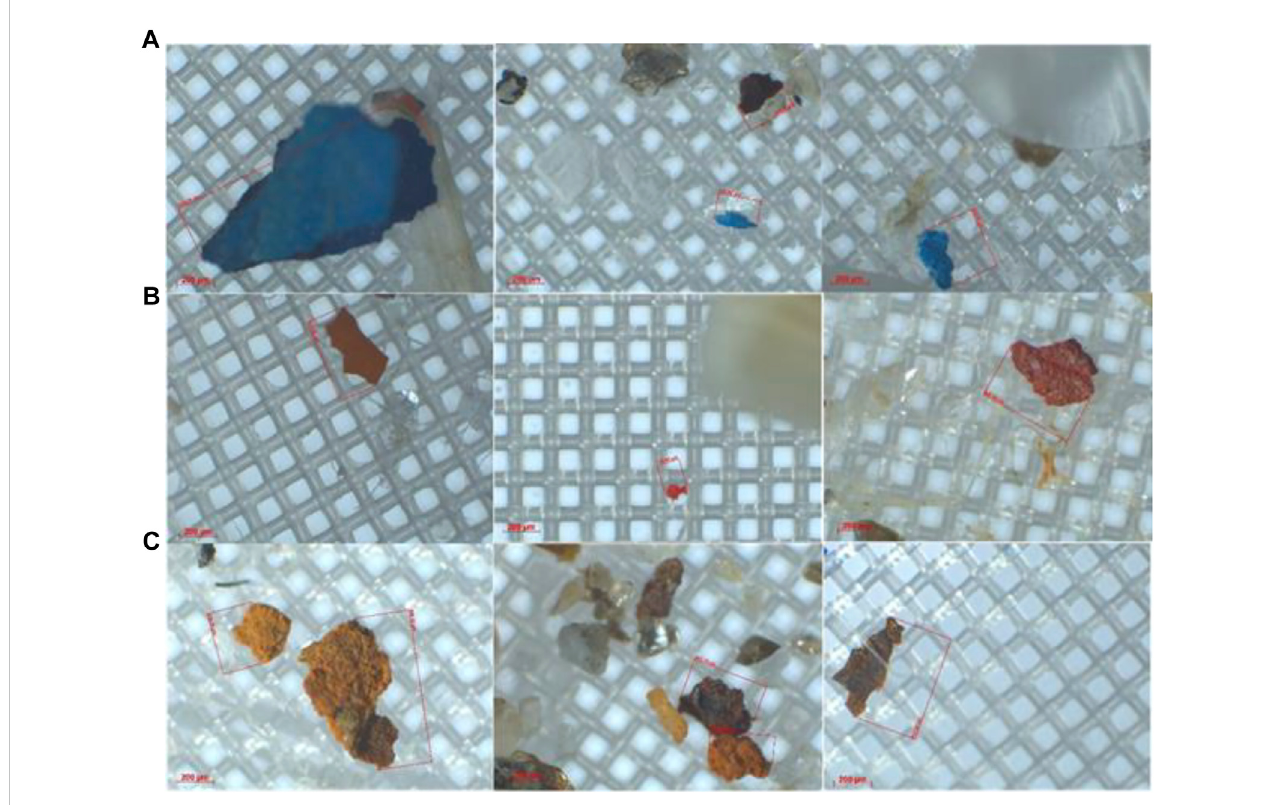
FIGURE 2 Examples of blue (A) , red (C) , and brown (B) particles detected with LM in manta trawl